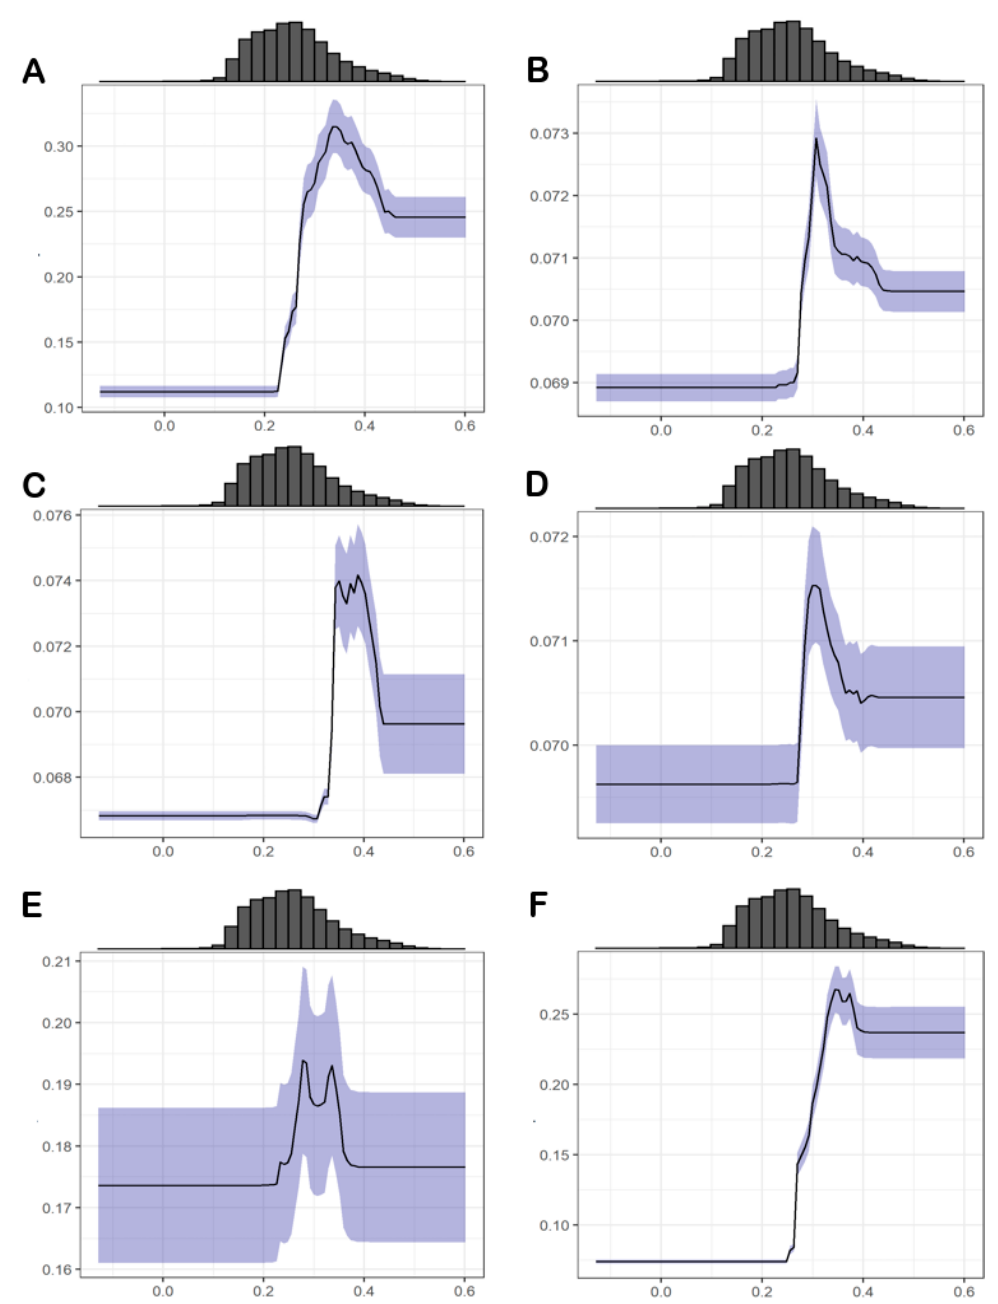
Figure A5. Response curves (average of all GBM models ± ½ std.-deviation) showing habitat suitability variation as function of EVI, for ( A ) MSD, ( B ) PRC, ( C ) T . lusitanica , ( D ) T . ebejeri , ( E ) T . semiaptera and ( F ) T . iberica .